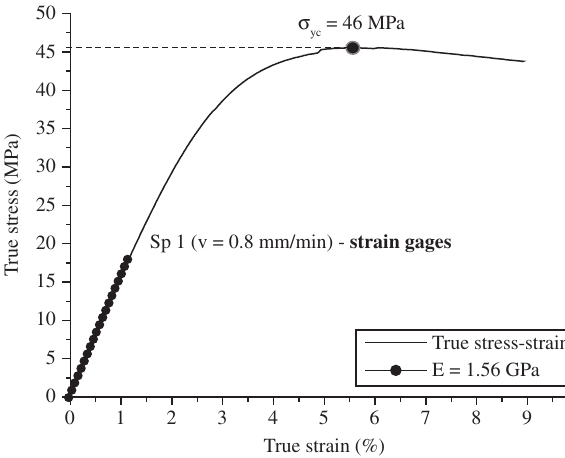
Figure 9. Young modulus and yield stress (strain gage): quasi-static